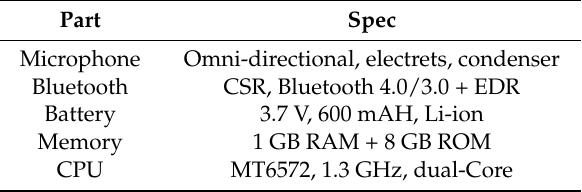
Table 1. Specification list of the device HW.